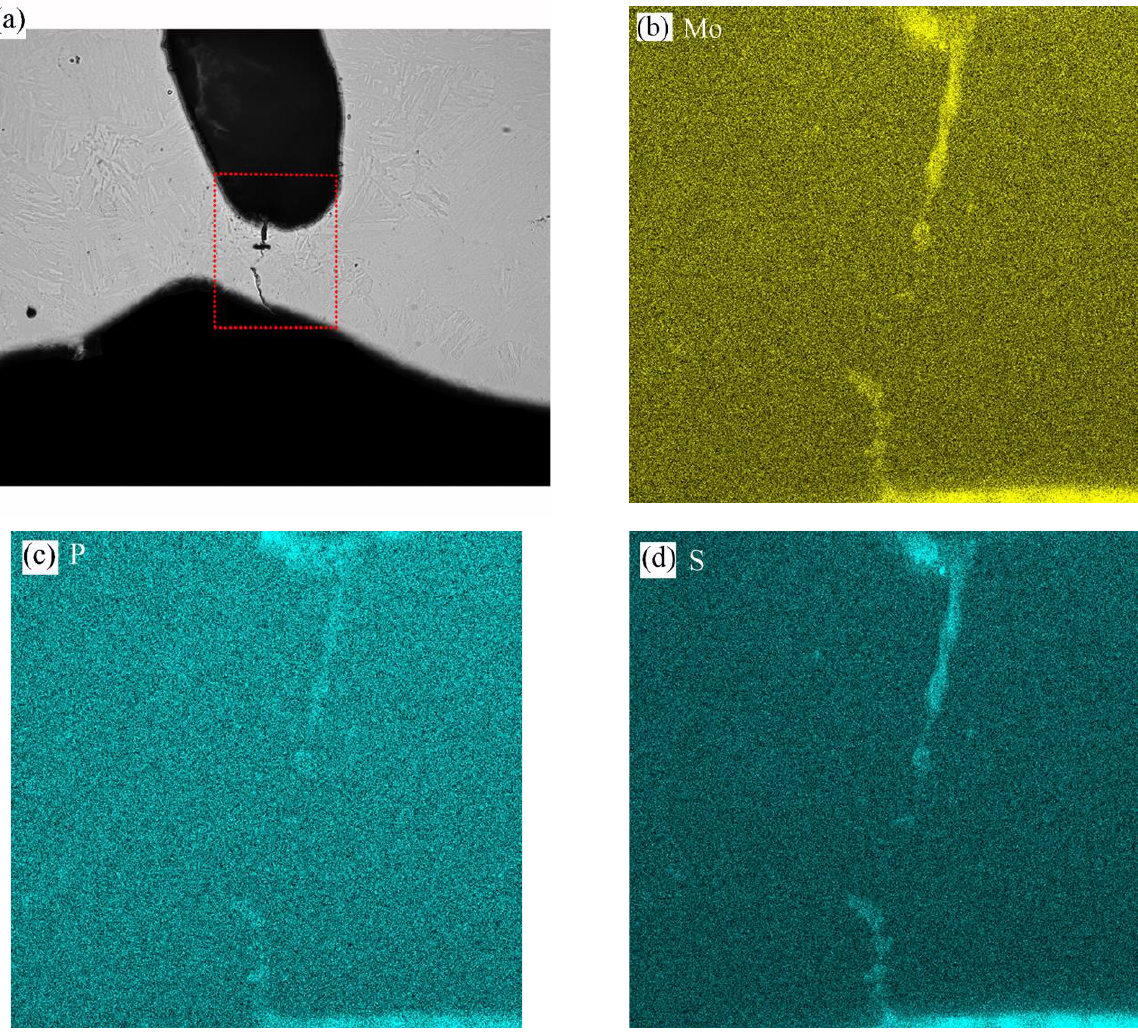
Figure 20. Chemical composition distribution of location B: ( a ) OM picture; ( b ) Mo; ( c ) P; ( d ) S.